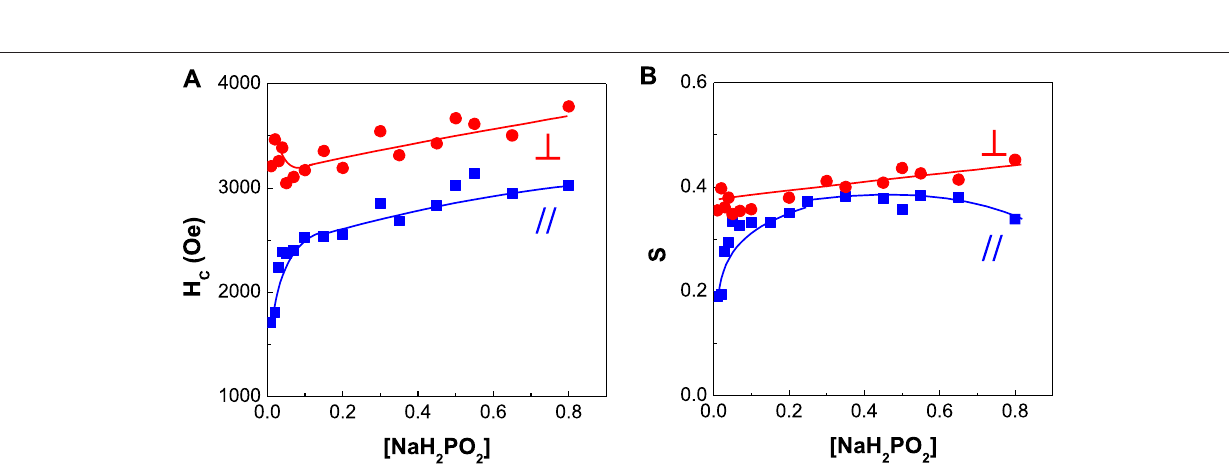
FIGURE 9 | Dependence of coercivity and squareness of CoPtP thin fi lms on NaH 2 PO 2 concentration (A) coercivity and (B) squareness.